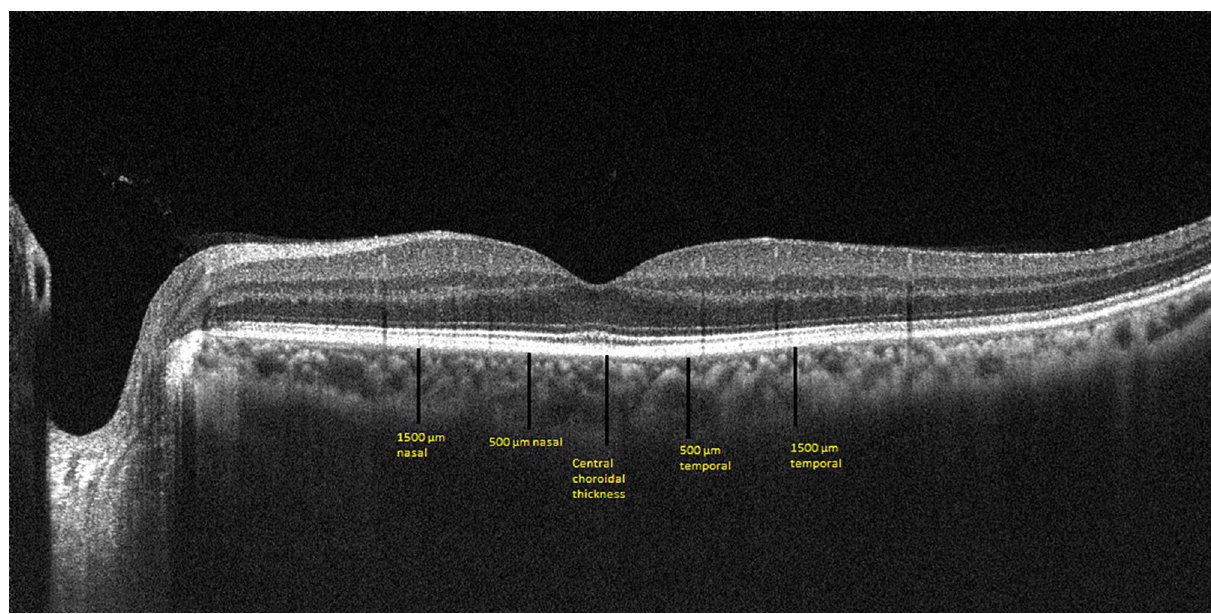
Figure 1. Choroidal thickness measurements on optical coherence tomography (OCT). Vertical lines are drawn from retinal pigment epithelium to